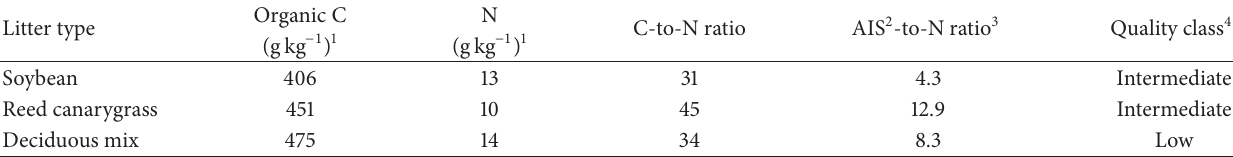
Table 1: Characteristics of litter added to microcosms containing riparian soil from along the Pike River in southern Qu´ebec. Litter type